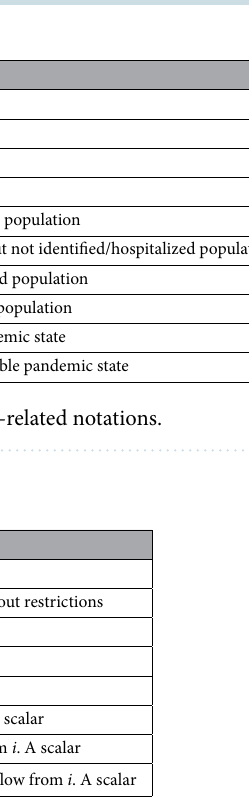
Table 3. The summary of mobility-related notations. Subscript ∗ can be either d or p